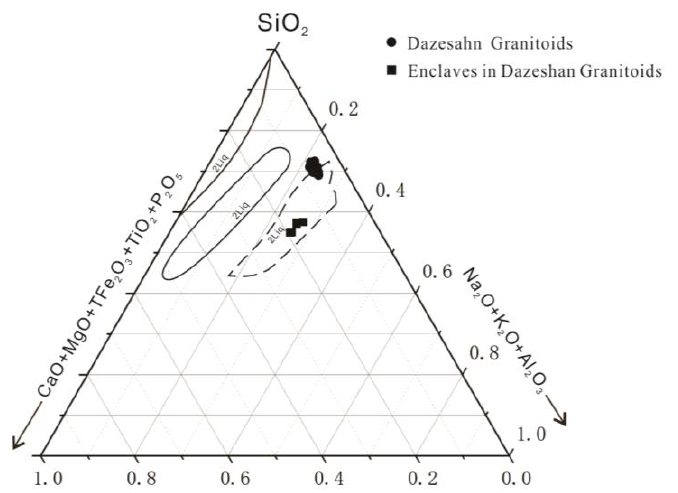
Figure 10. Plots for the Dazeshan granitoids and their enclaves on the Greig diagram. Fields for liquid immiscibility are from [80,95].